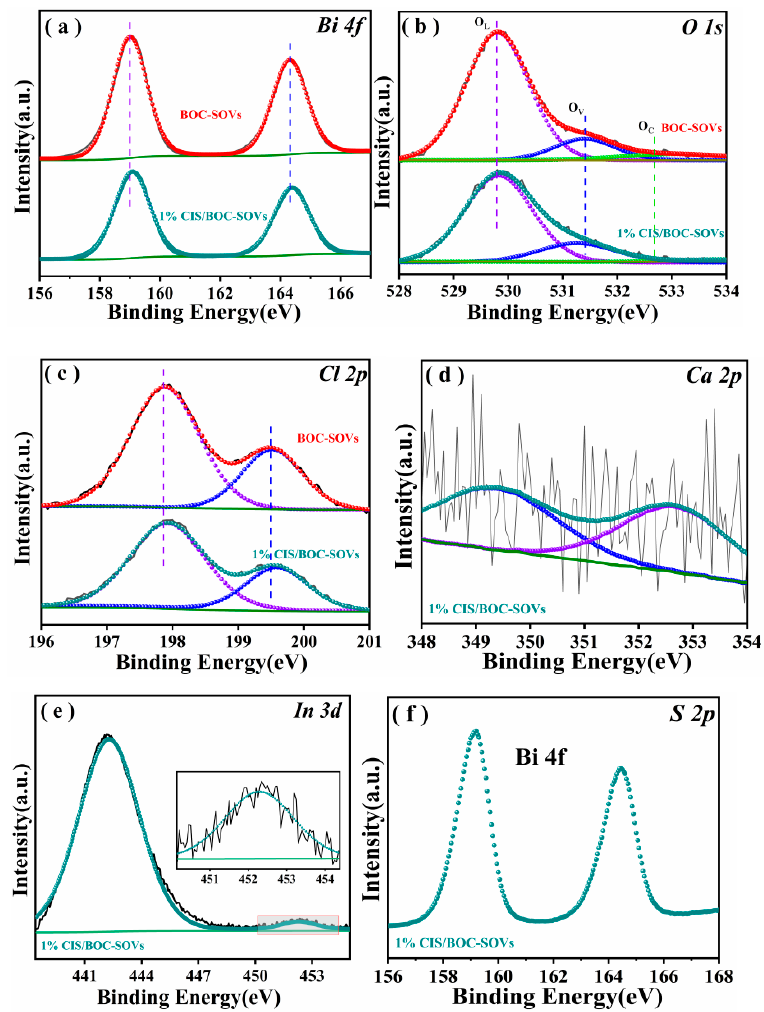
Figure 3. XPS spectra of ( a ) Bi 4f, ( b ) O 1s, ( c ) Cl 2p, ( d ) Ca 2p, ( e ) In 3d, and ( f ) S 2p.